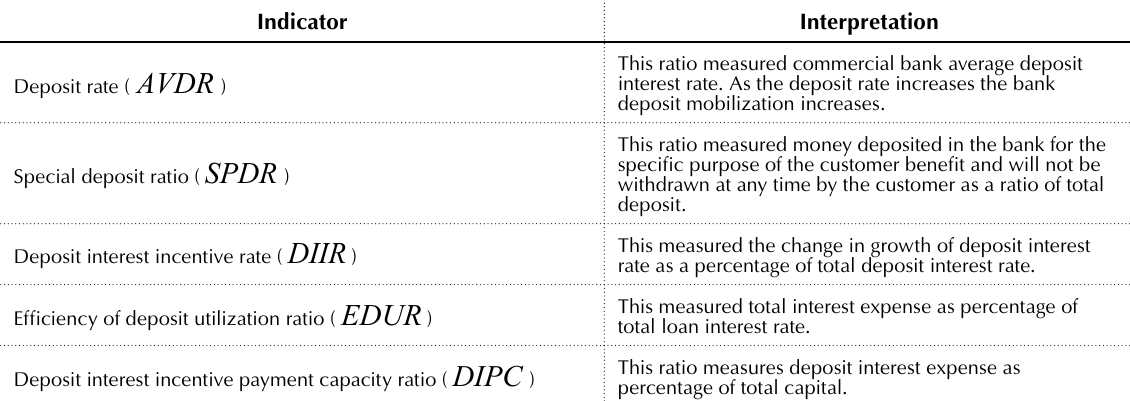
Table 8. Measures of discrete market deposit interest incentive ratio